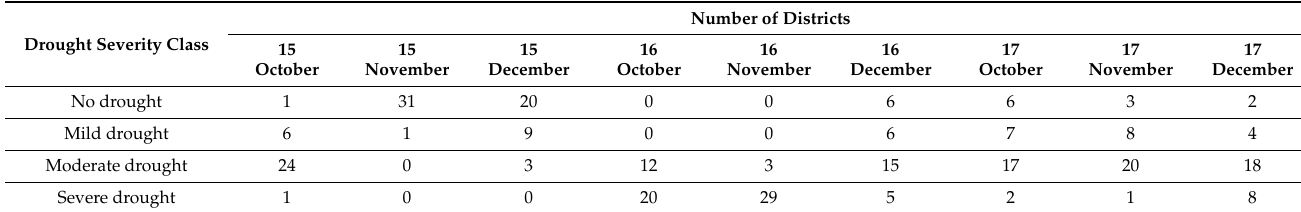
Table 8. Summary of the number of districts falling into different severity